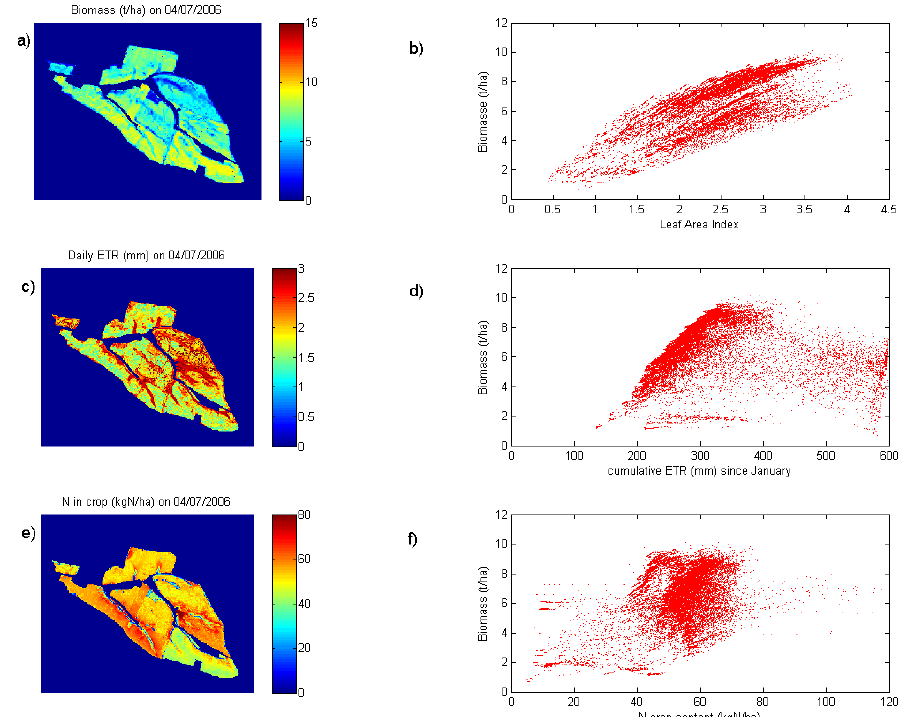
Figure 7. Sunflower development simulated for the year 2006 after reinitializing soil parameters: ( a ); Simulation of the biomass on 14 July 2006 with the relationship between LAI this day and Biomass ( b ); The corresponding evapotranspiration for this day ( c ); Biomass of each pixel is shown as a function of cumulative evapotranspiration from January to July ( d ); The corresponding N content in crop on 4 July ( e ); High heterogeneity between biomass and nitrogen content in sunflower is simulated because the nitrogen stress factors do not influence biomass growth in these simulations ( f ).